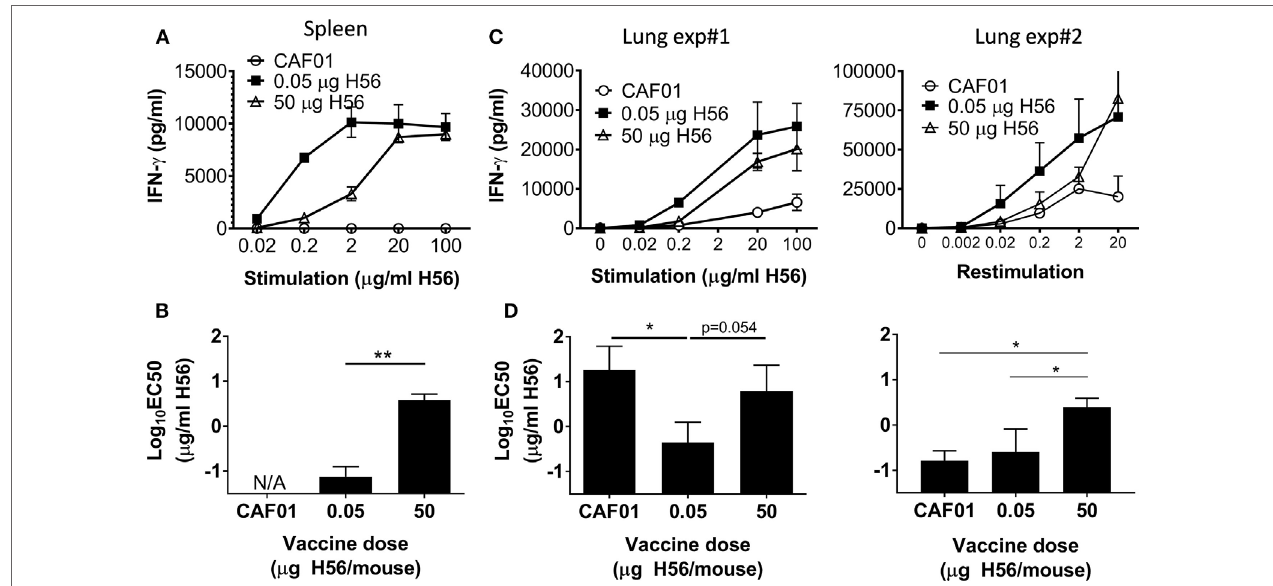
FigUre 4 | High dose post-exposure H56 vaccination leads to reduced functional avidity. One week post the final vaccination in the post-exposure model, splenocytes (a) or lung cells (c) from control (open circle) and H56-vaccinated (0.05 µg closed square; 50 µg open triangle) mice were cultured for 3 days with varying concentrations of H56, and IFN- γ release in the culture supernatants was measured by ELISA. (a) Data points represent mean ± SD of triplicate cultures of pooled cells from three mice/group (from Exp. 4 in Figure S1B in Supplementary Material). (B) EC 50 was calculated using data from (a) ; bars, mean ± SD per vaccine group. This experiment was repeated twice. (c,D) IFN- γ release and calculated functional avidity (EC 50 ) of lung cells from two independent experiments in which subsequent week 37 protection was not assessed. (c) Data points represent mean ± SD of triplicate cultures pooled from five mice/group. (D) Bars indicate mean ± SD EC 50 calculated from (c) . Statistical differences between functional avidity of vaccine groups were assessed by a one-way ANOVA and Tukey’s posttest for multiple comparisons. * p < 0.05, ** p < 0.01. No further identical experiments with lung T cell avidity were